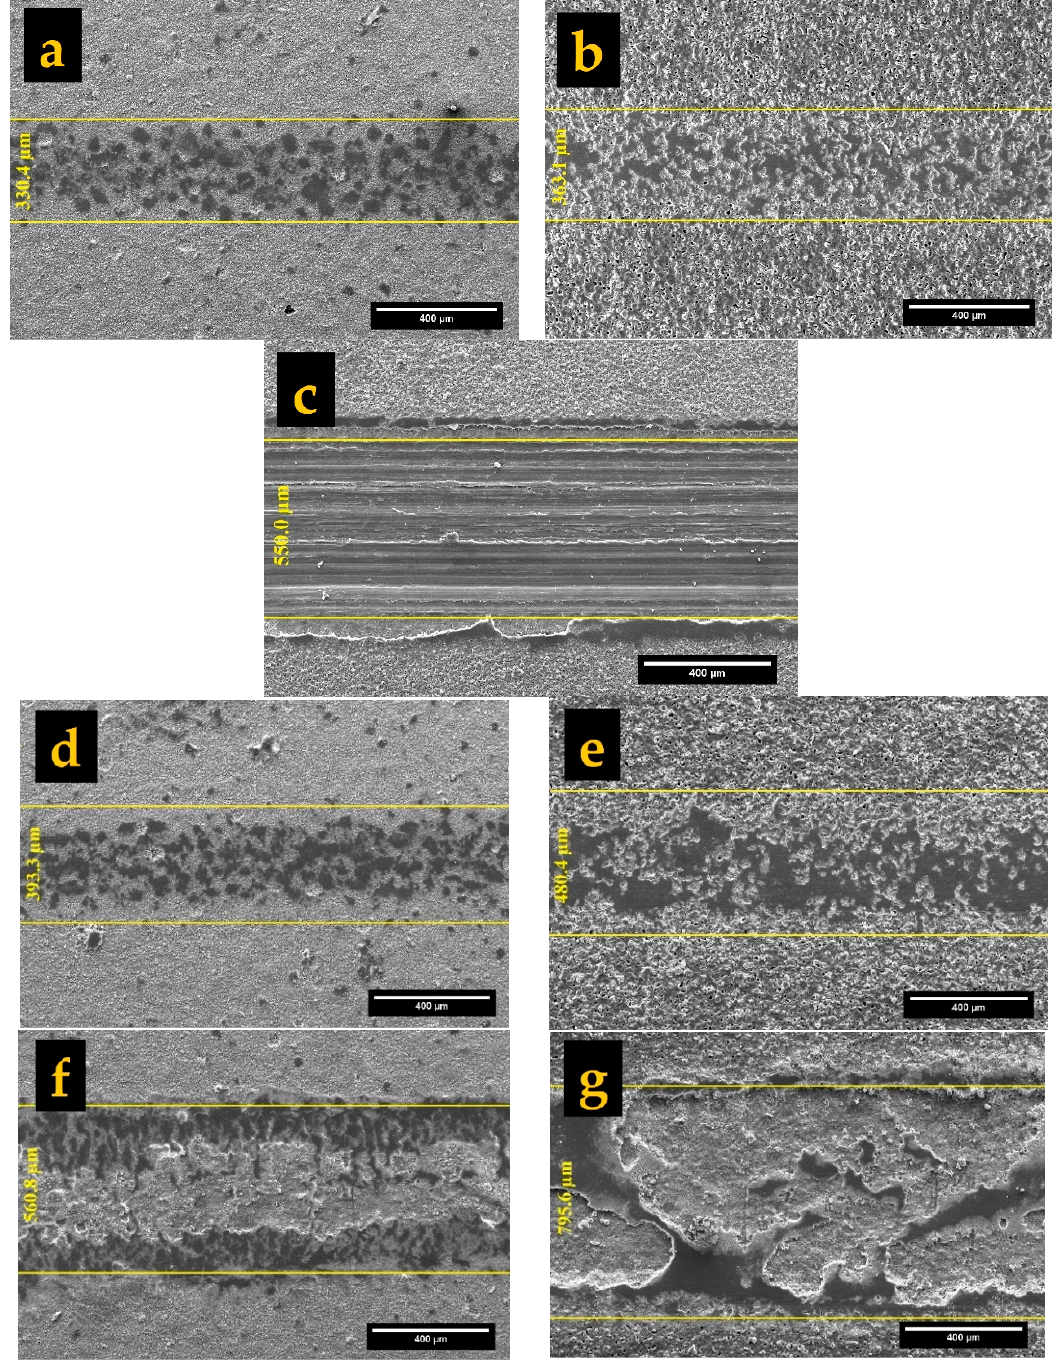
Figure 9. Wear tracks of PEO coatings after dry-sliding tests; ( a ) Al-15 min, ( b ) Ph-15 min, ( c ) Si-15 min,